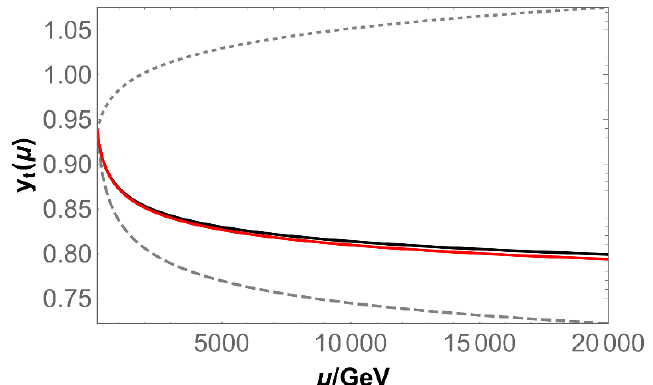
Figure 1 . The running of the top Yukawa coupling in di(cid:11)erent approximations: grey-dashed: only (cid:11) s running; grey-dotted: only y 3 running; black: exact solution [19]; red: our approximation, see t eqs. (4.3),